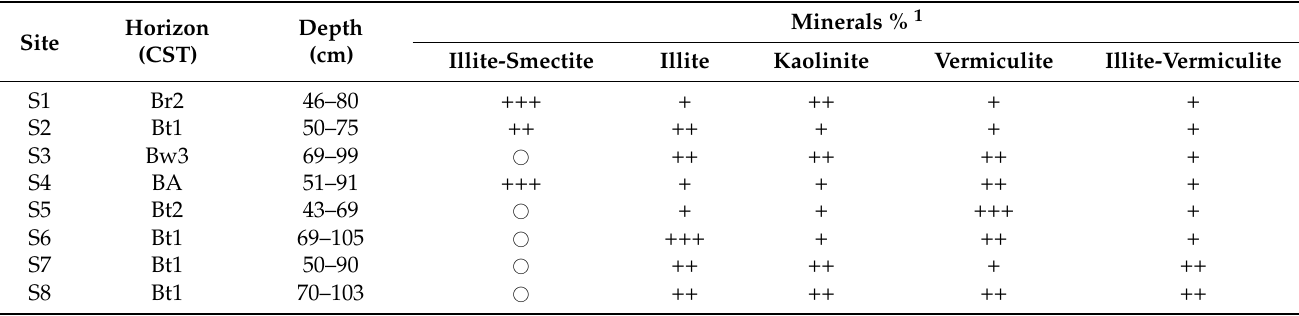
Table 5. X-ray diffraction analysis data for soils in the clay derived from carbonate rocks along a climosequence in a subtropical mountain,